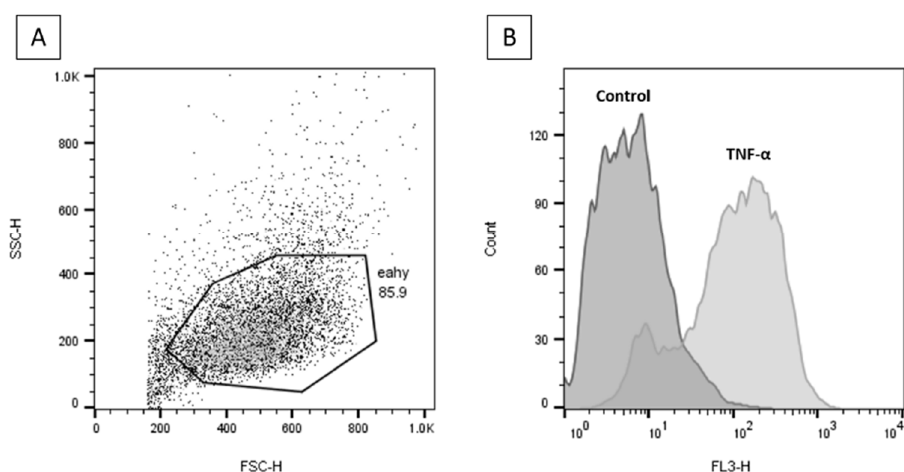
Figure 8. Flow cytometry plots for cell surface ICAM-1 analysis. ( A ) Gated unstained TNF- α stimulated EA.hy926 cells. ( B ) Gated unstimulated (Control) and TNF- α stimulated (PE-CyTM 5)-conjugated CD54 (ICAM-1) antibody stained EA.hy926 cells.